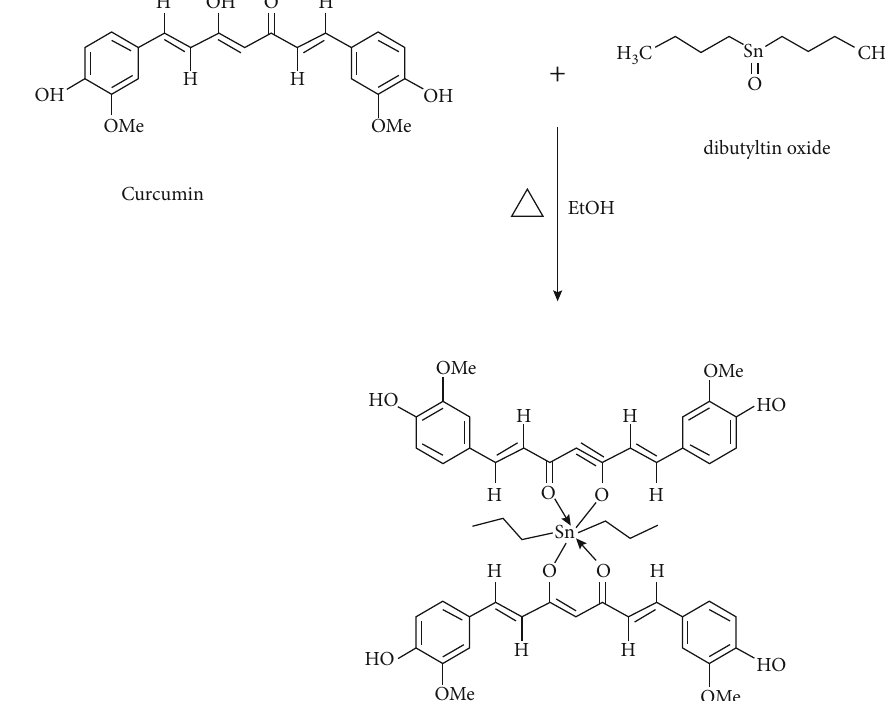
Figure 1: Scheme showing the used procedure for the synthesis of the metallic complex used as corrosion